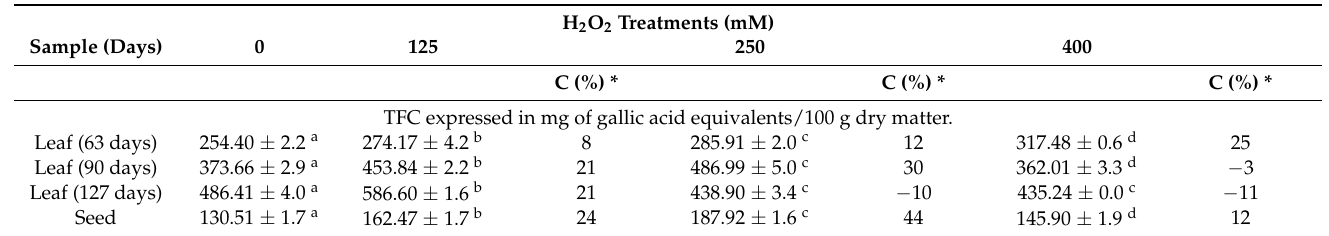
Table 4. Results of the content of total phenolic compounds (TFC) in amaranth leaf and seed ( Amaranthus hypochondriacus L.).